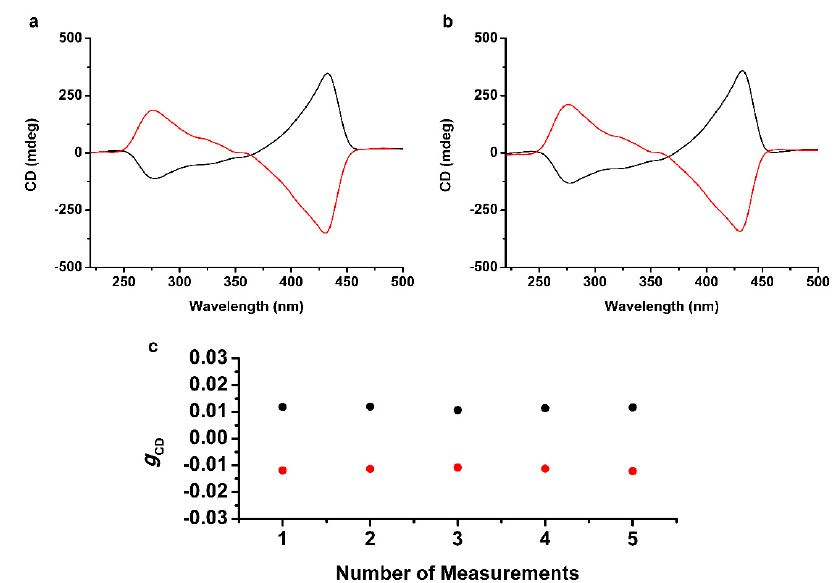
Figure 4. Locking of the induced handedness by circularly polarized ultraviolet light (CPUL). ( a ) CD spectra of polymerized homochiral thin film of TSADA, prepared by irradiation of CPUL with the same handedness of the self-assembled structures. Irradiation of l -CPUL was performed to the homochiral supramolecular thin film prepared by l -CPL (black line) and irradiation of r -CPUL was performed to the homochiral supramolecular thin film prepared by r -CPL (red line). ( b ) Maintenance of the CD activity of the polymerized homochiral thin film of TSADA against irradiation of CPL with the opposite handedness. CD spectra were recorded after irradiation of r -CPL to the polymerized homochiral thin film prepared by l -CPL, l -CPUL (black line), and l -CPL to the polymerized homochiral thin film prepared by r -CPL and r -CPUL (red line). ( c ) The g CD values of the polymerized homochiral thin film of TSADA prepared by using l -CPL and l -CPUL (black dots) or r -CPL and r -CPUL (red dots). The measurements were performed at the center and the four edges of the substrates to cover all areas of the thin